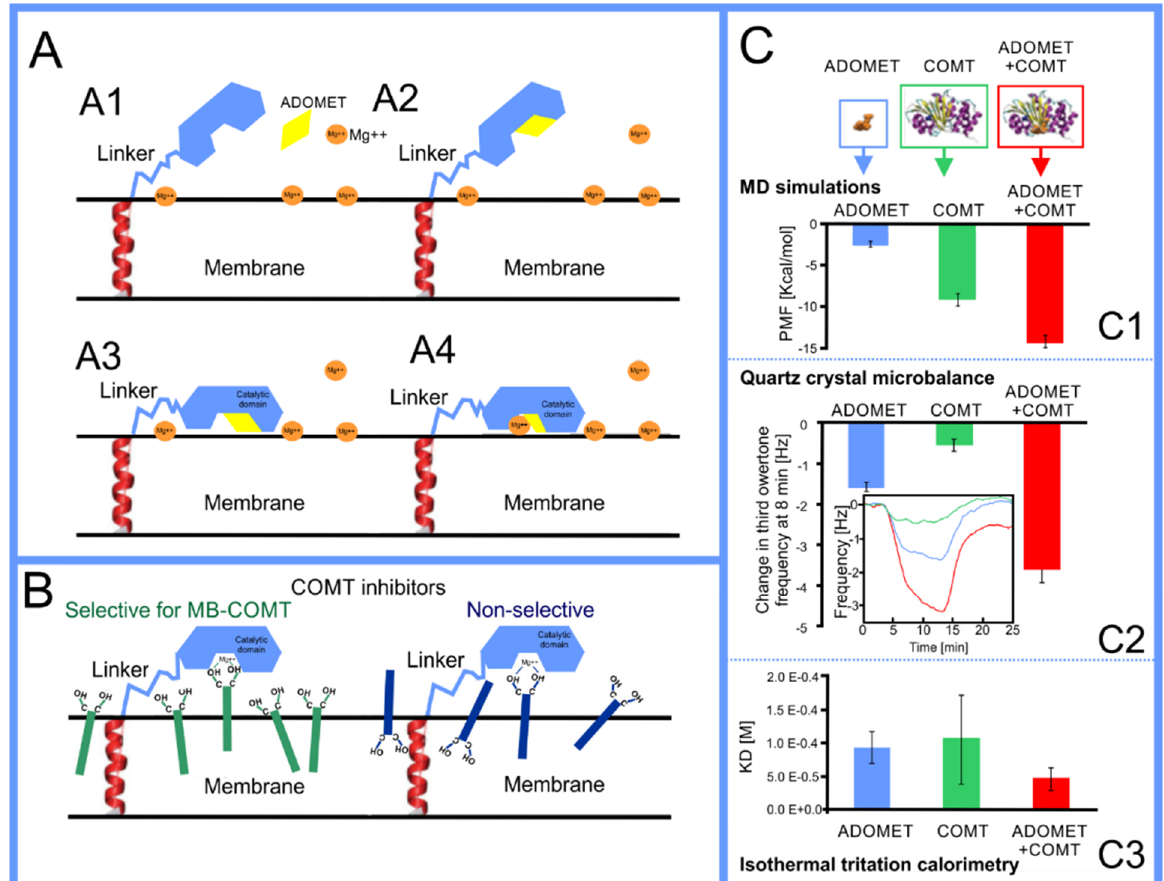
Figure 22. ( A ) Schematic of the catalytic mechanism of MB–COMT. ( B ) The behavior of MB–COMT selective vs. non– selective inhibitors in the membrane. ( C ) Quantitative experimental and computational results for the interactions of the ADOMET and catalytic domain of COMT in complex and separately with lipids: ( C1 ) the free energy changes calculated computationally with umbrella sampling methods; ( C2 ) quartz crystal microbalance (QCM) frequency changes during interaction of COMT with the lipid bilayer; ( C3 ) dissociation constant from liposomes determined by isothermal calorimetry. Reproduced with permission from ref. [381]. Copyright 2018 the Royal Society of Chemistry.